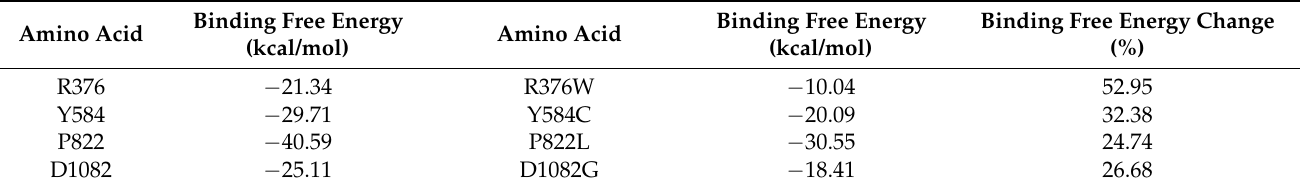
Figure 3F. The binding free energy was calculated using the molecular mechanics Poisson– Boltzmann surface area method [28], and the results showed that the binding affinity of artemisinin with wild-type PDR1 ( − 21.34 kcal/mol) was stronger than that with point mutant PDR1 R376W ( − 10.04 kcal/mol) (Table 2). Similar results were also obtained in other point mutation such as Y584C, P822L and D1082G. These simulation results demonstrated that PDR1 mutations had a lower sensitivity to artemisinin than wild-type PDR1. Then, based on the catalytic mechanism, the distance between single point mutant residues (R376W, Y584C, P822L, D1082G) and artemisinin was analyzed. The distance between mutant residue R376W and artemisinin was 9.8 Å, which was longer than that of wild-type residue R376 (5.9 Å). Other mutant residues showed similar simulation results, that is, the distances between artemisinin and Y584, P822 and D1082 were 3.9 Å, 4.5 Å and 3.4 Å, respectively. They were all shorter than the distance between point mutant residues Y584C (9.0 Å), P822L (5.7 Å), D1082G (5.6 Å). From these results, we found that the distance between amino acid residues and artemisinin was partly correlated with the phenotype of the artemisinin effect. Artemisinin had no effect on the PDR1 Y584C mutant strain even on 50 µ M artemisinin, and other mutant strains were all resistant to artemisinin compared with the wild-type strain (Figure 3B). The growth inhibition by broth assay also showed that the PDR1 Y584C mutant strain was more resistant to artemisinin than other mutant strains. Therefore, molecular dynamics simulations had the same trends as the phenotype experiments, suggesting that PDR1 played an important role in artemisinin’s action on C. glabrata . Table 2. Effect of point mutations on the binding energy of artemisinin interaction with